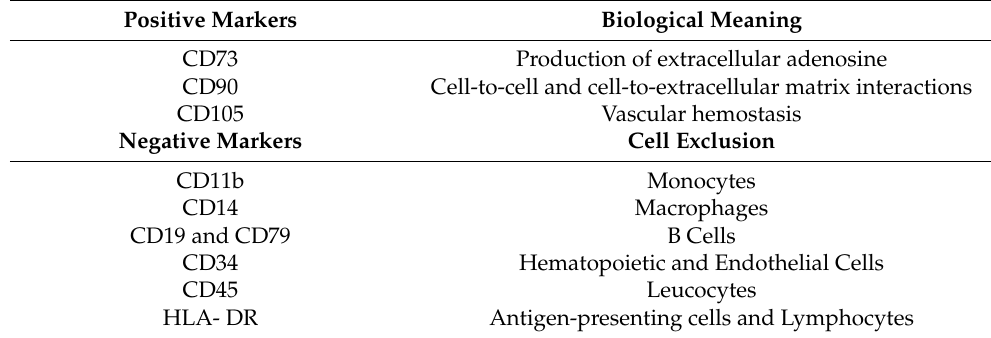
Table 1. Positive and negative markers proposed by the ISCT for MSCs identification. Adapted from